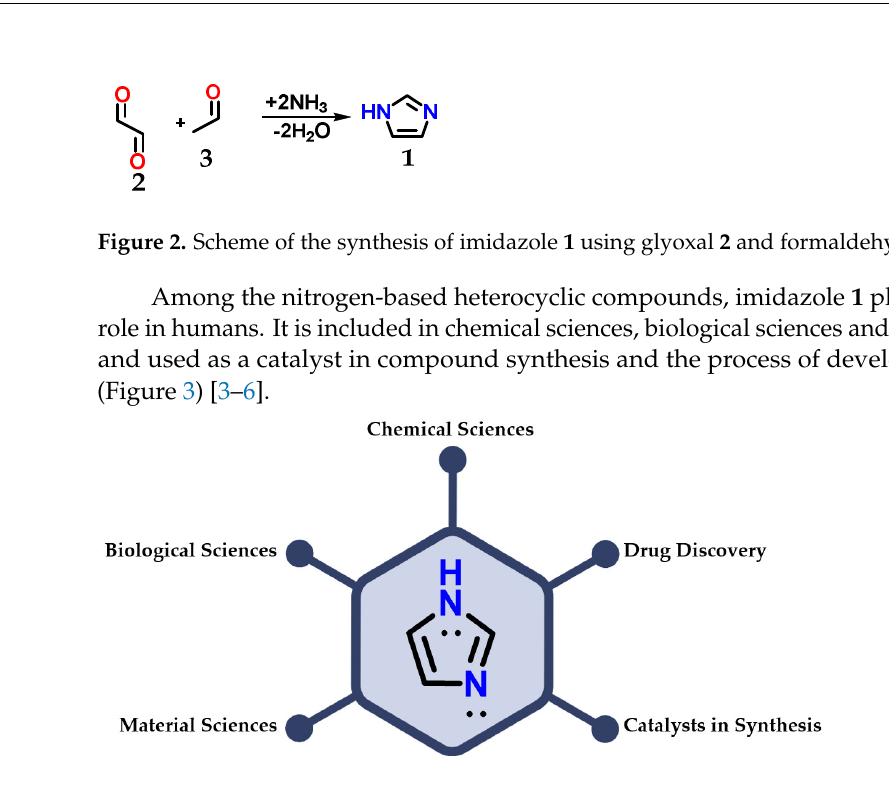
Figure 3. Applications of imidazole 1 in different areas of knowledge.